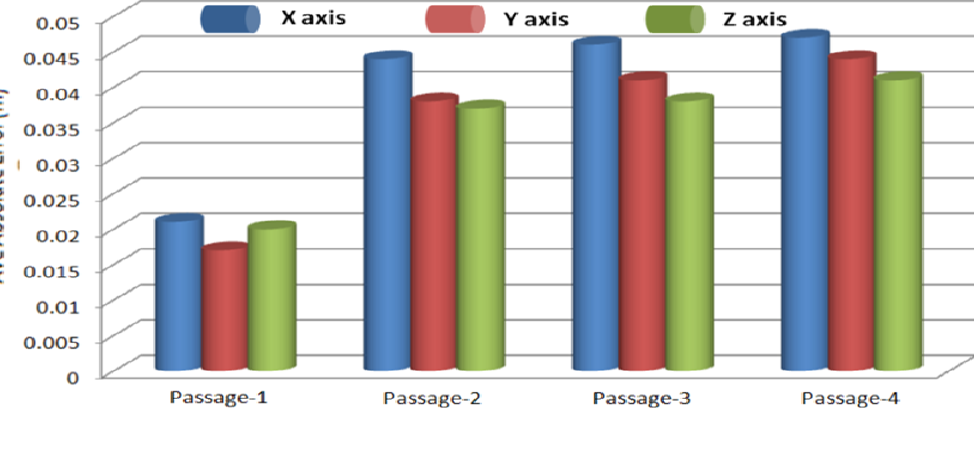
Figure 18. Average absolute errors in x , y and z (height)